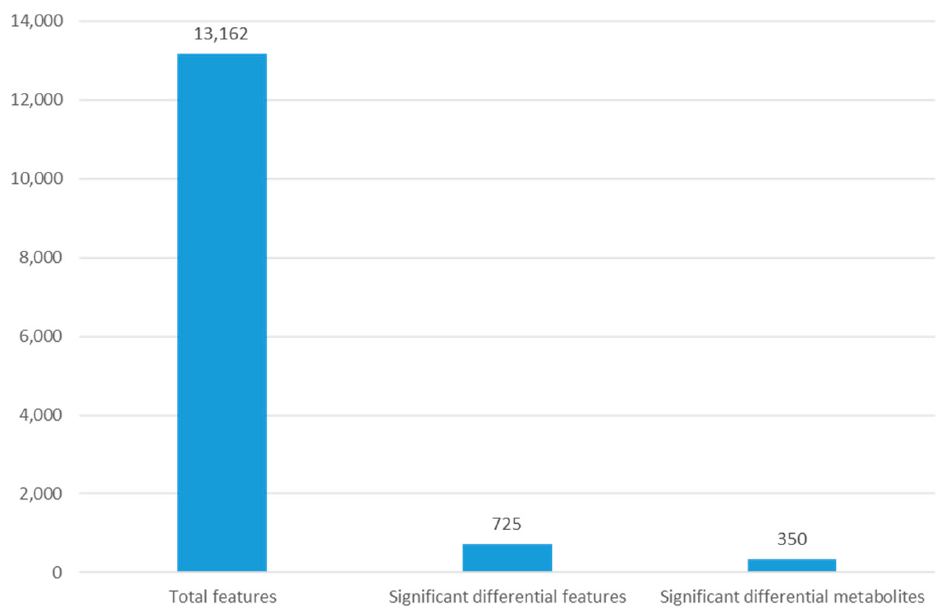
Figure 4. The number of features observed for metabolomic analysis of G. duodenalis after metroni- dazole exposure.